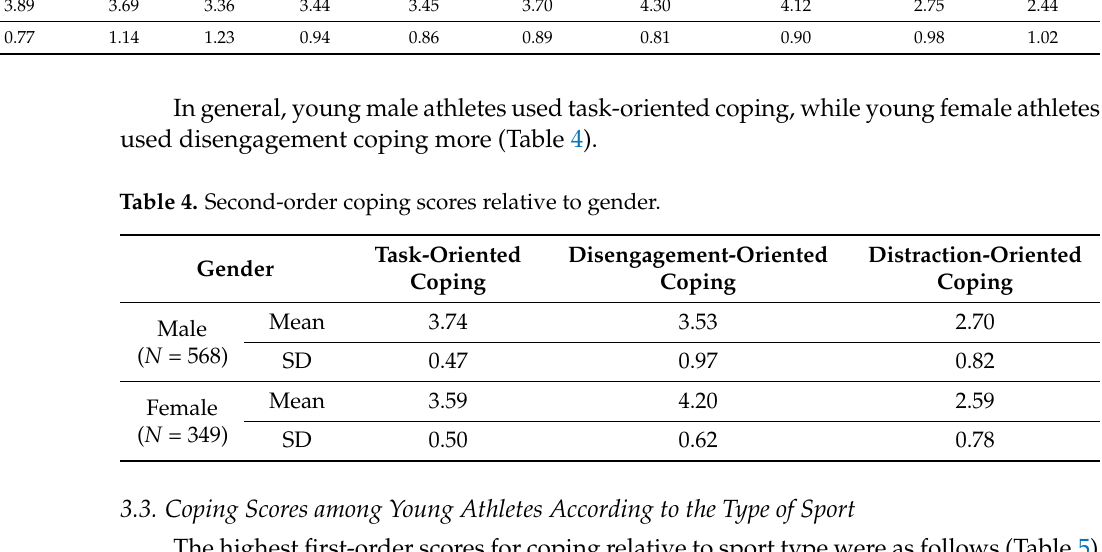
The highest first-order coping strategy scores in young male athletes were: Logical